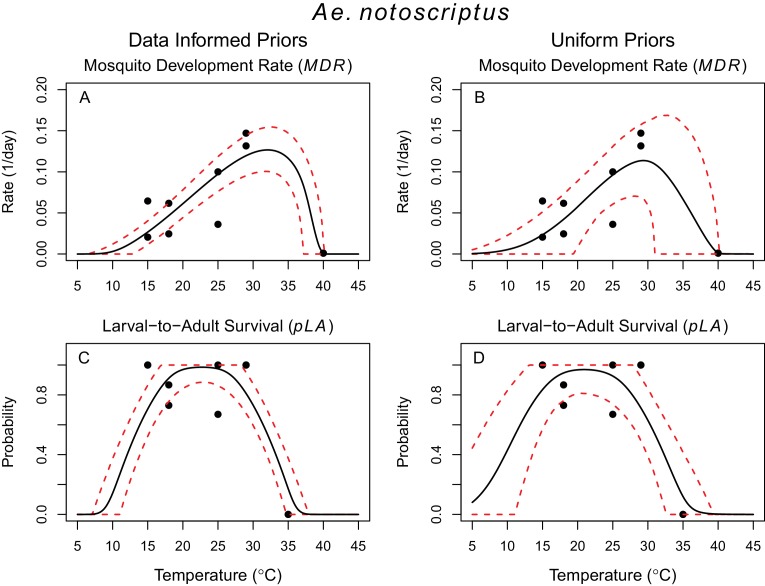
Thermal responses of Ae. notoscriptus.